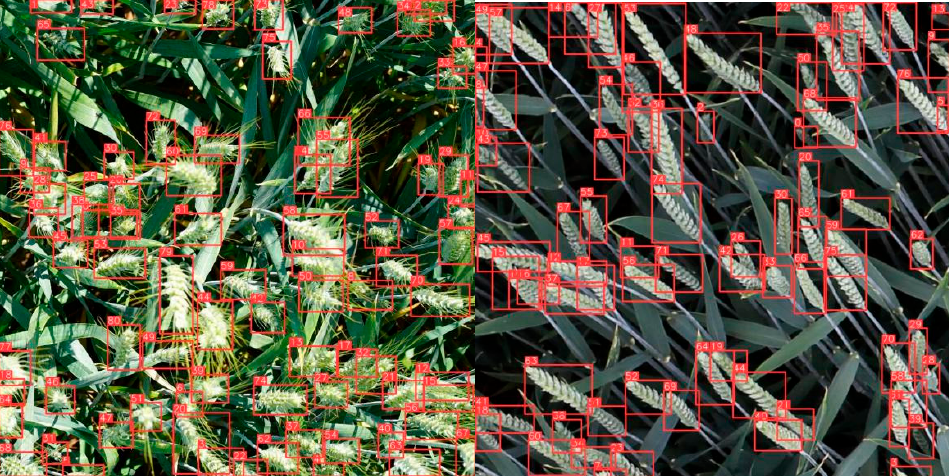
Figure 13. Examples of wheat ear detection results .